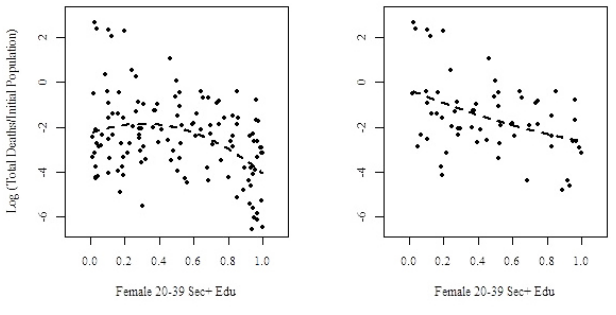
Fig. 1 . Relationship between the log of disaster deaths (per 1000 of 1980 population) and the mean of female education (proportion with secondary and higher education among women aged 20 to 39) over the period 1980 to 2010 for all 130 countries (left side) and 63 countries with one or more disasters on average per year (right